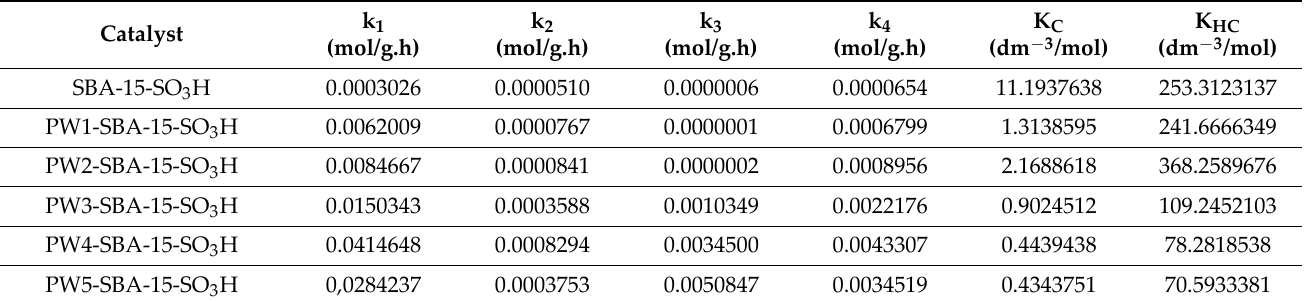
Table 2. Model parameters obtained by fitting the model to experimental data.